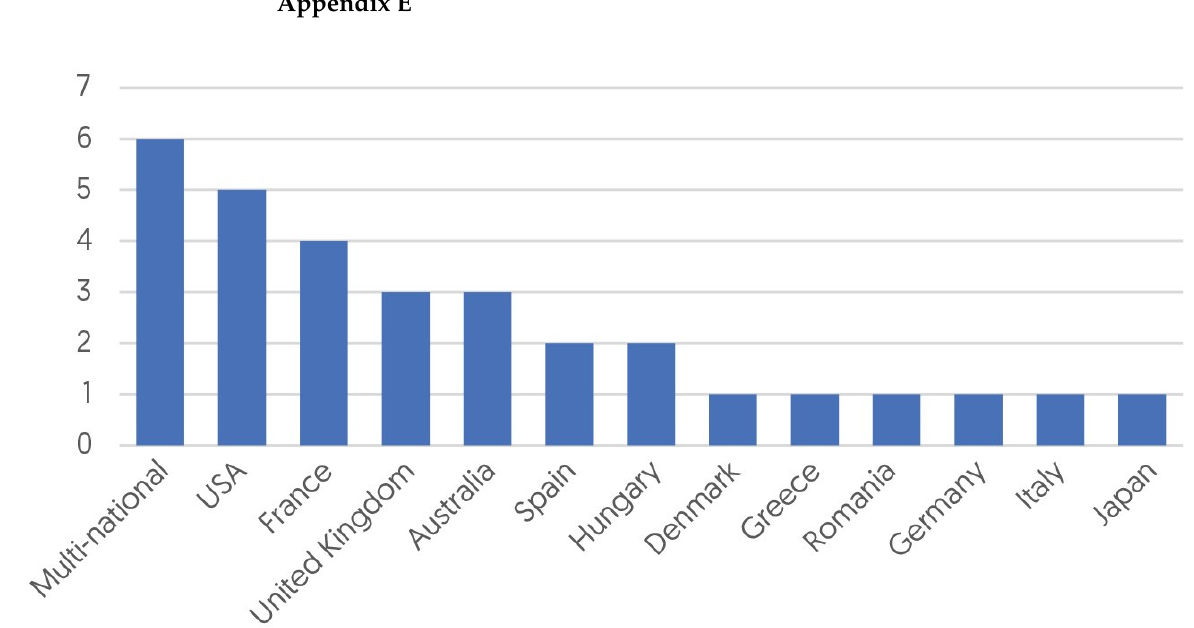
Figure A4. Geographical location of case studies.